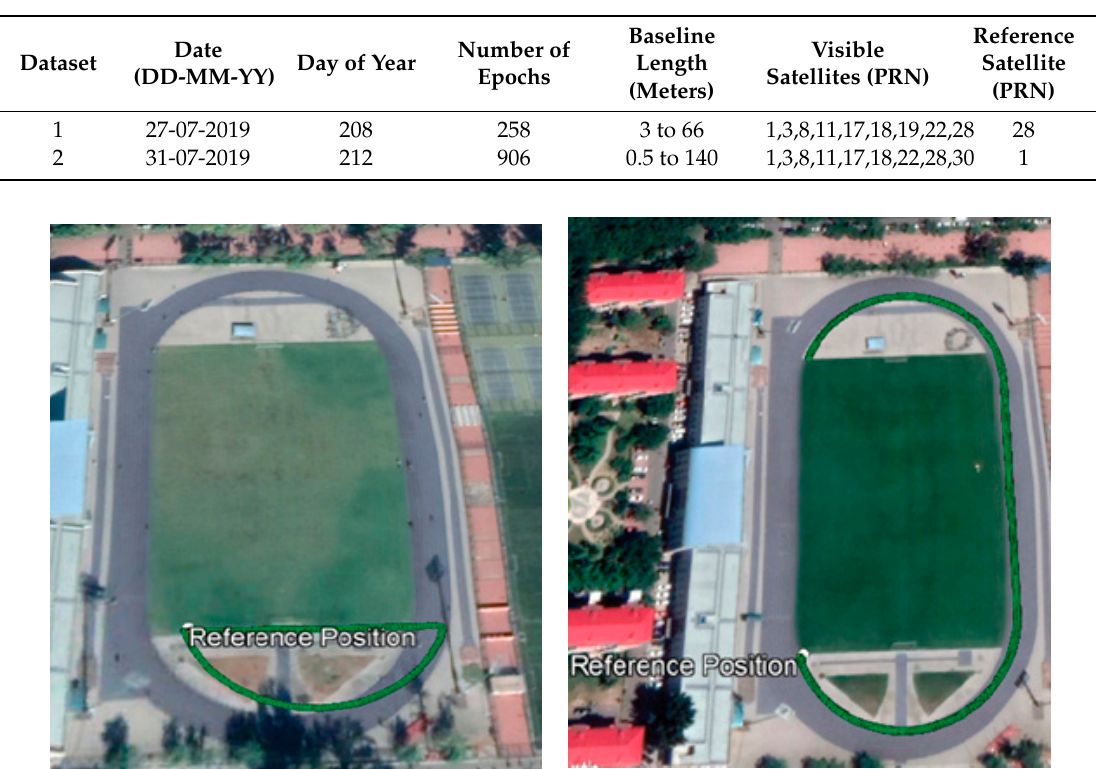
Table 2. Details of datasets used for testing.